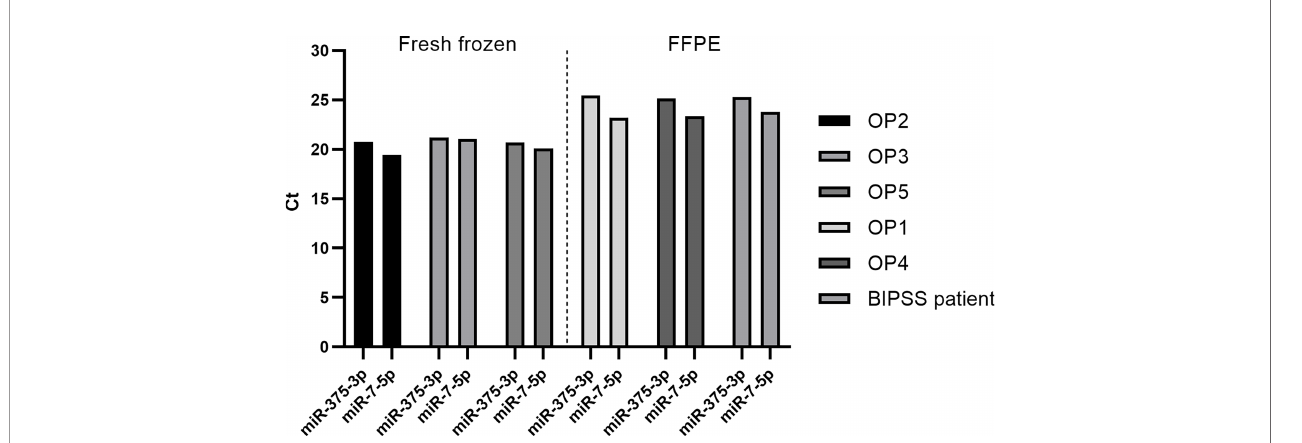
FIGURE 7 | Expression of miR-7-5p and miR-375-3p in ACTH secreting PitNET tissue samples. The expression is represented by Ct values on Y axis. OP2, OP3 and OP5 belong to fresh frozen tissue samples group while OP1, OP4 and BIPSS patient belong to FFPE samples group. The expression of both miRNAs is stable within ACTH secreting PitNET tissues. There is a difference in Ct values between FFPE samples and fresh frozen